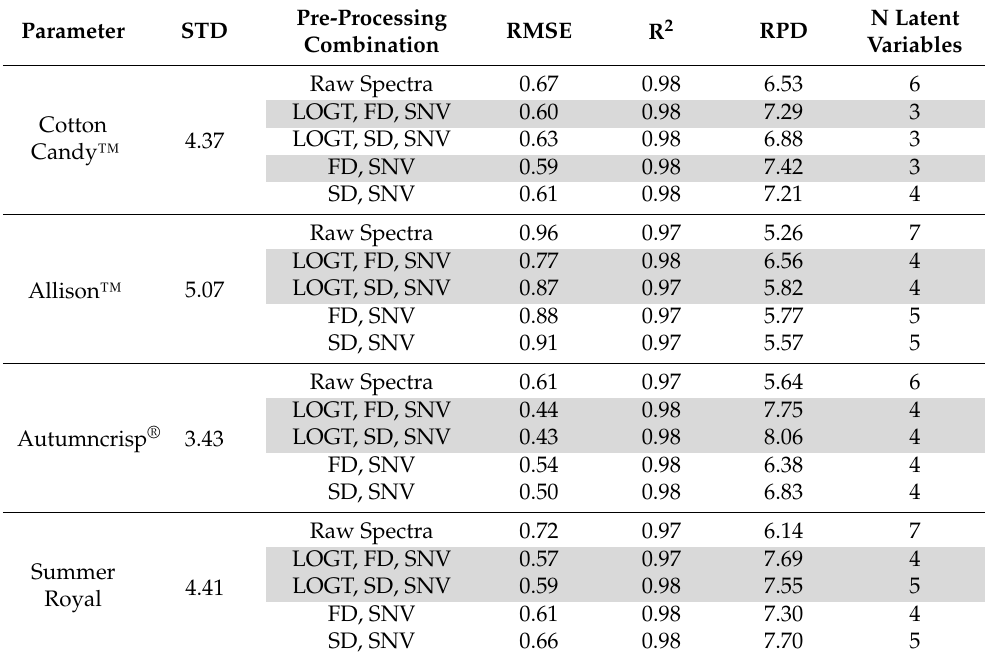
N Latent Variables